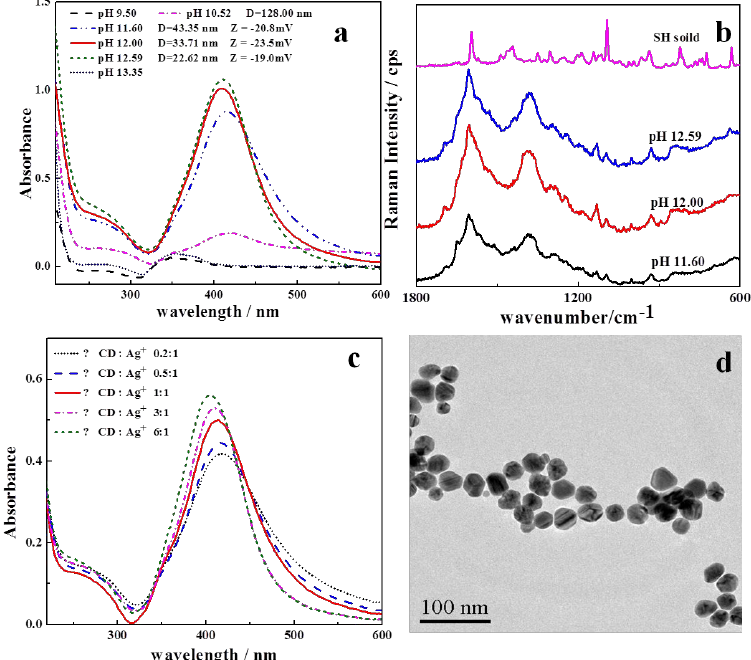
Figure 3. ( a ) UV-Vis spectra of Ag NP suspensions prepared with different synthesis pH values ranging from 9.5 to 13.35; ( b ) SERS spectra of SH on β-CD/Ag NPs synthesized at different pH values; ranging from 9.5 to 13.35; ( b ) SERS spectra of SH on β -CD/Ag NPs synthesized at different pH values; ( c ) UV-Vis spectra of Ag NPs obtained at different ratio of AgNO 3 and β-CD: 0.2:1, 0.5:1, 1:1, 3:1, 6:1, ( c ) UV-Vis spectra of Ag NPs obtained at different ratio of AgNO 3 and β -CD: 0.2:1, 0.5:1, 1:1, 3:1, 6:1, and 12:1; ( d ) TEM micrograph of β-CD/Ag obtained with AgNO 3 and β-CD at a ratio of 1:1 ratio. and 12:1; ( d ) TEM micrograph of β -CD/Ag obtained with AgNO 3 and β -CD at a ratio of 1:1